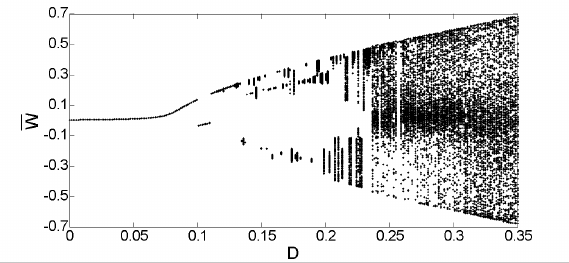
Fig. 3: Bifurcation diagram of the deflection with variation of the damage